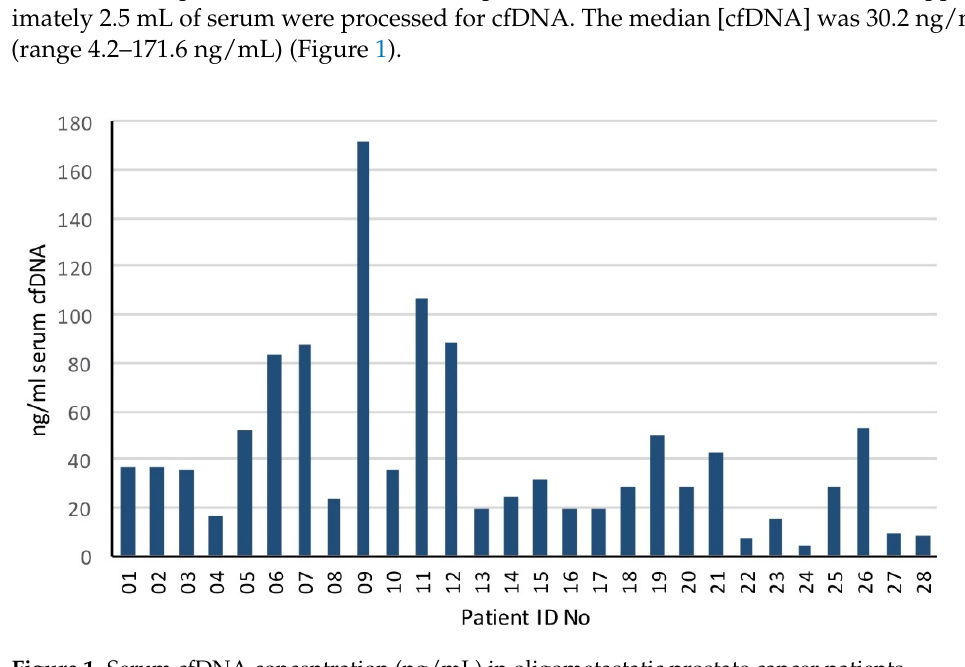
Figure 1. Serum cfDNA concentration (ng/mL) in oligometastatic prostate cancer patients.